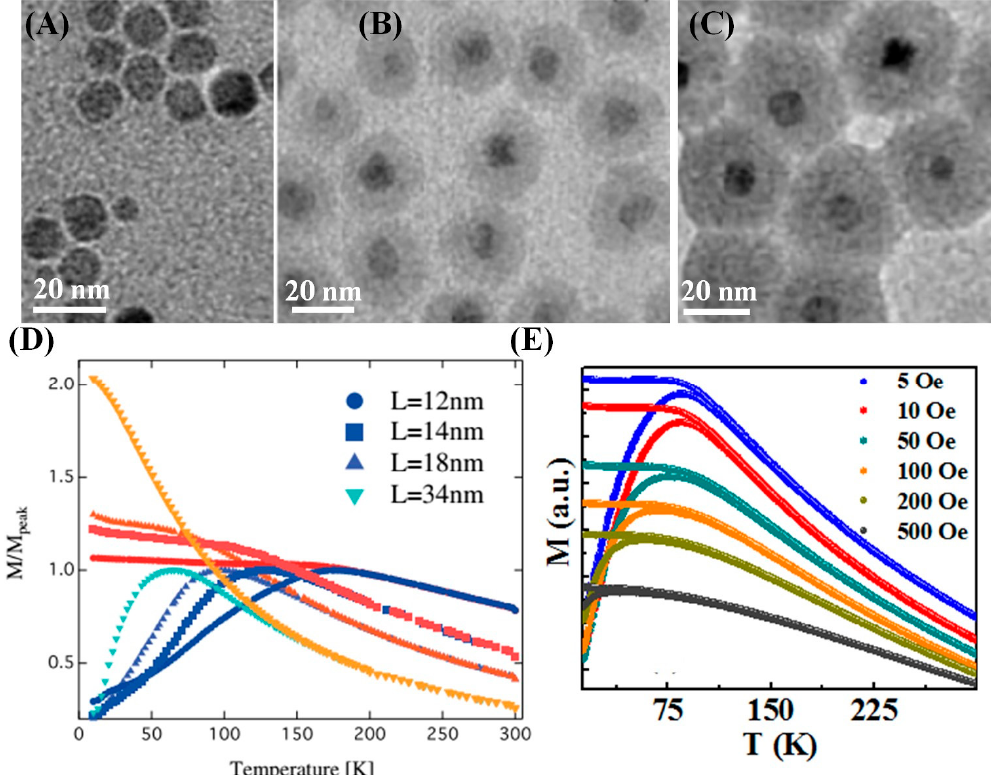
Figure 14. ( A – C ) TEM images of γ -Fe 2 O 3 NPs (average diameter = 11 nm), γ -Fe 2 O 3 / SiO 2 NPs with SiO 2 layer thickness, L = 26 nm, and 34 nm, respectively. ( D ) Temperature-dependent magnetization of the γ -Fe 2 O 3 / SiO 2 NPs with SiO 2 layer thickness, L = 12, 14, 18, and 34 nm under ZFC and FC conditions [125]. ( E ) The ZFC and FC magnetization are measured at the indicated field values for 4 nm Fe 3 O 4 nanoparticles [43].